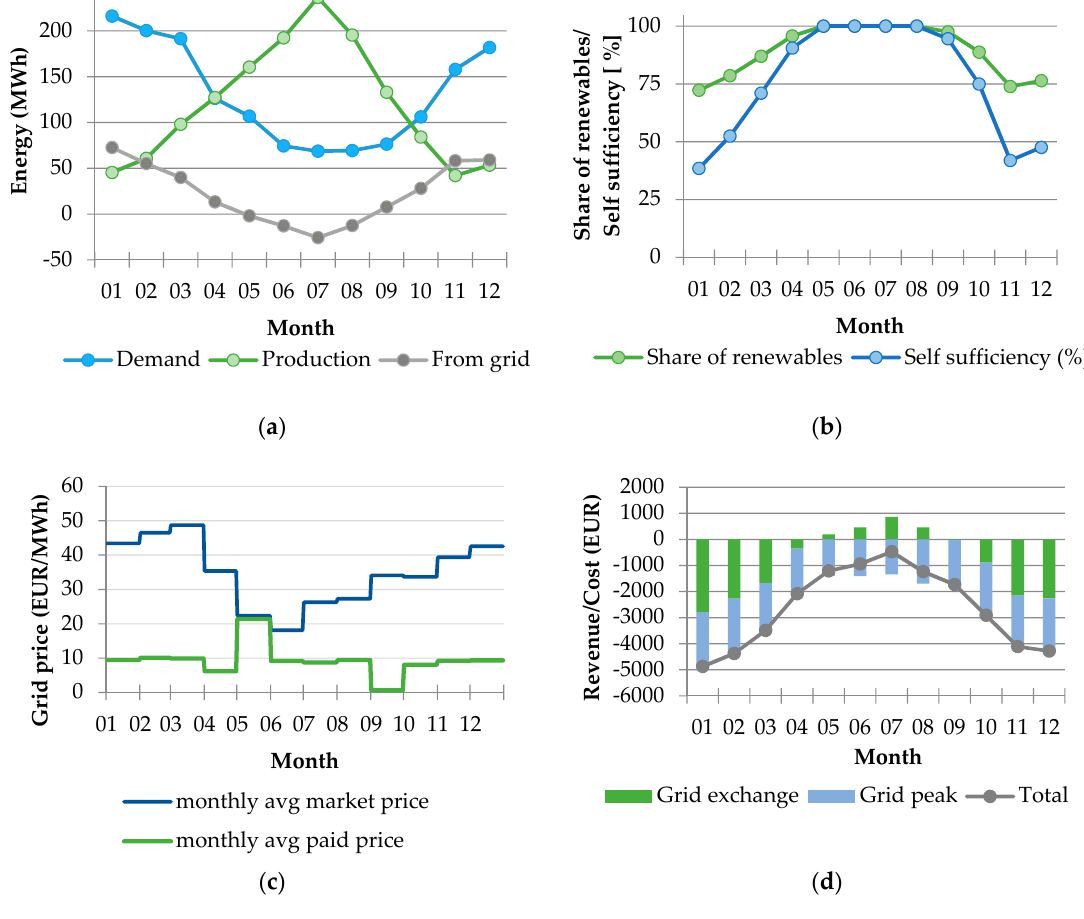
Figure 2. Baseline scenario: ( a ) Monthly primary energy exchanges; ( b ) monthly share of renewables and rate of self-sufficiency; ( c ) grid price; ( d ) monthly revenue/cost